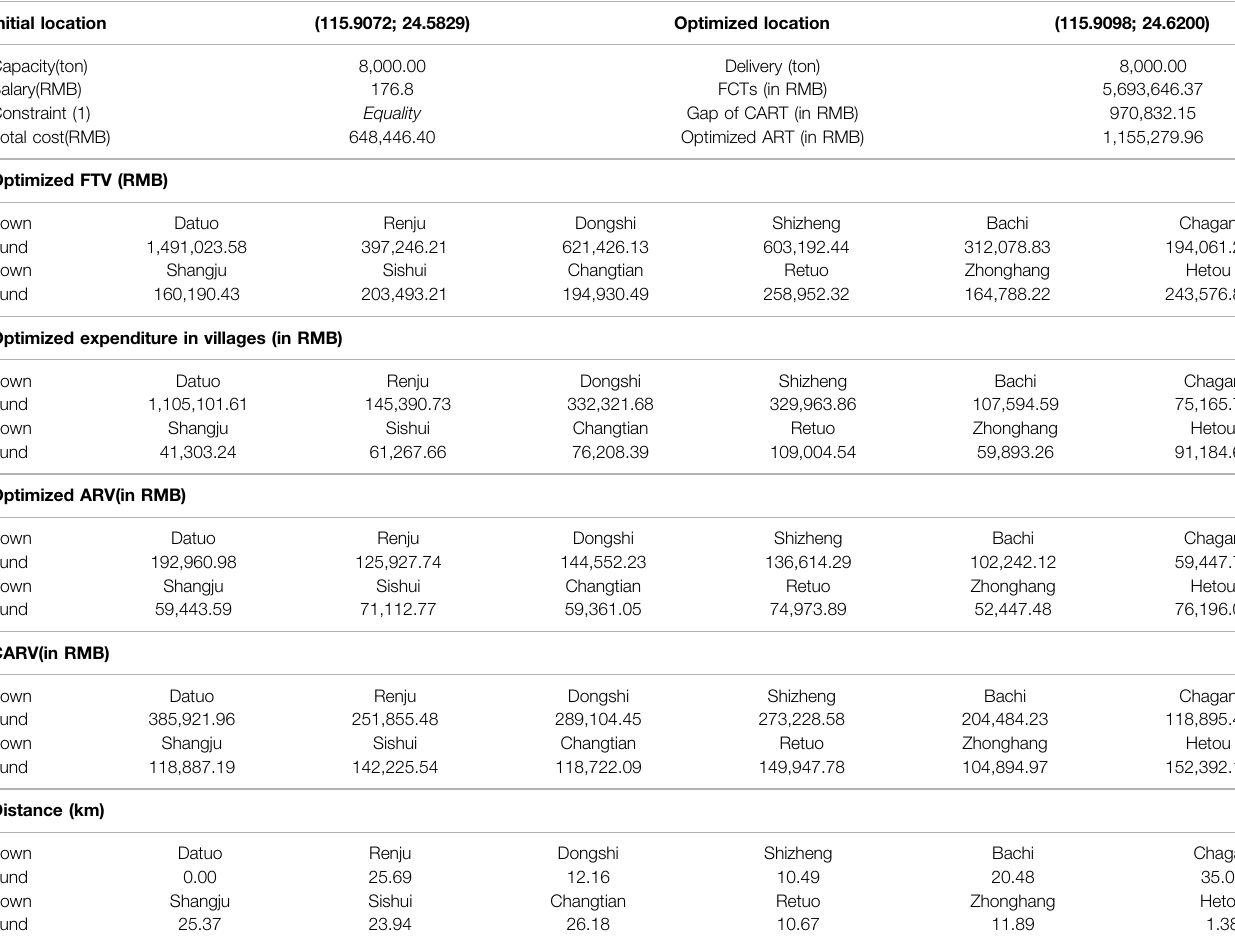
TABLE 2 | Optimization result given equality (3) and capacity = 8,000 tons for constraint